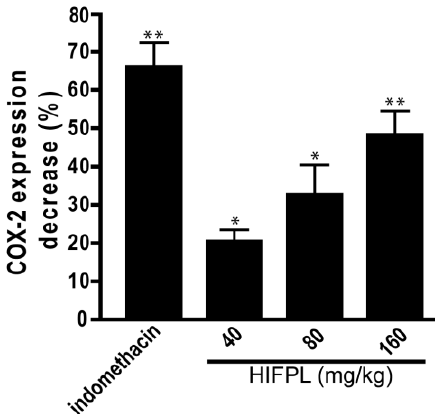
Figure 3. The effect of HIFPL on COX-2 expression in carrageenan-induced paw edema. Mice paws were cut and fixed in buffered formalin and COX-2 expression was quantified. HIFPL was tested at 40, 80 or 160 mg/kg (per oral), and indomethacin (5 mg/kg, per oral) was used as a reference drug. The values are mean ± standard errors. * p < 0.05; ** p < 0.01 (ANOVA/Dunnett), compared to the solvent-treated group (set as 100% of COX-2 expression).